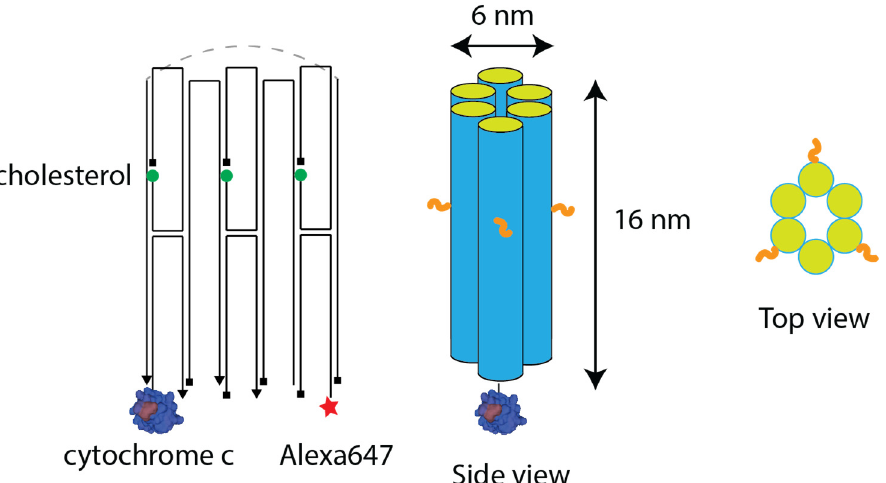
3D views. DNA tile strands are marked with arrows (3 (cid:48) end) and squares (5 (cid:48) ends). The length strands are marked with arrows (3 ′ end) and squares (5 ′ ends). The length of the tiles was 48 and 84 bases, respectively. to the 5 ′ and 3 ′ ends of two tiles, respectively, as indicated.